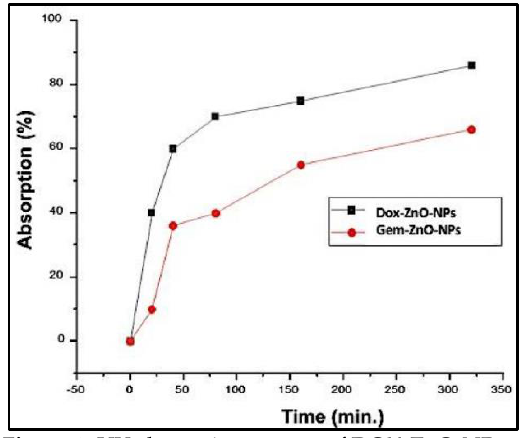
Crystals 2021 , 11 , 344 Figure 8. UV absorption spectra of DOX-ZnO-NPs and GEM-ZnO-NPs after 320 min. Figure 8. UV absorption spectra of DOX-ZnO-NPs and GEM-ZnO-NPs after 320 min.